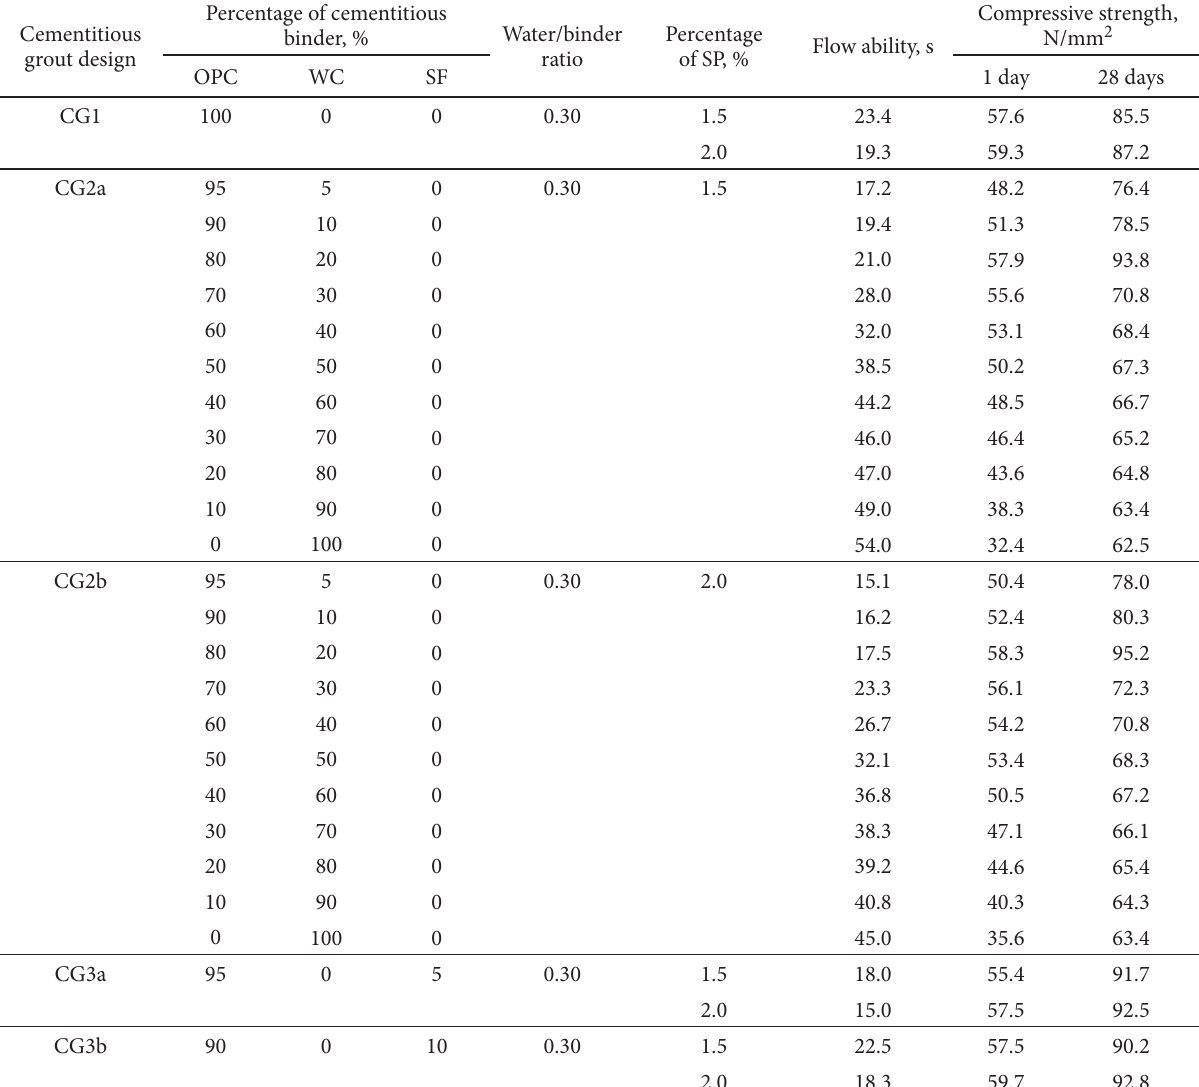
Table 2. Workability and compressive strength test results for different cementitious binders Cementitious grout